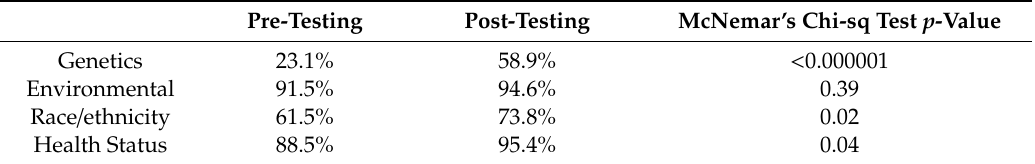
Table 2. Percentage of respondents who indicated 4 or 5 on a 5-point Scale (1 = least comfortable; 5 = most comfortable) regarding comfort level in discussing various types of risk factors for common disease with patients ( n =